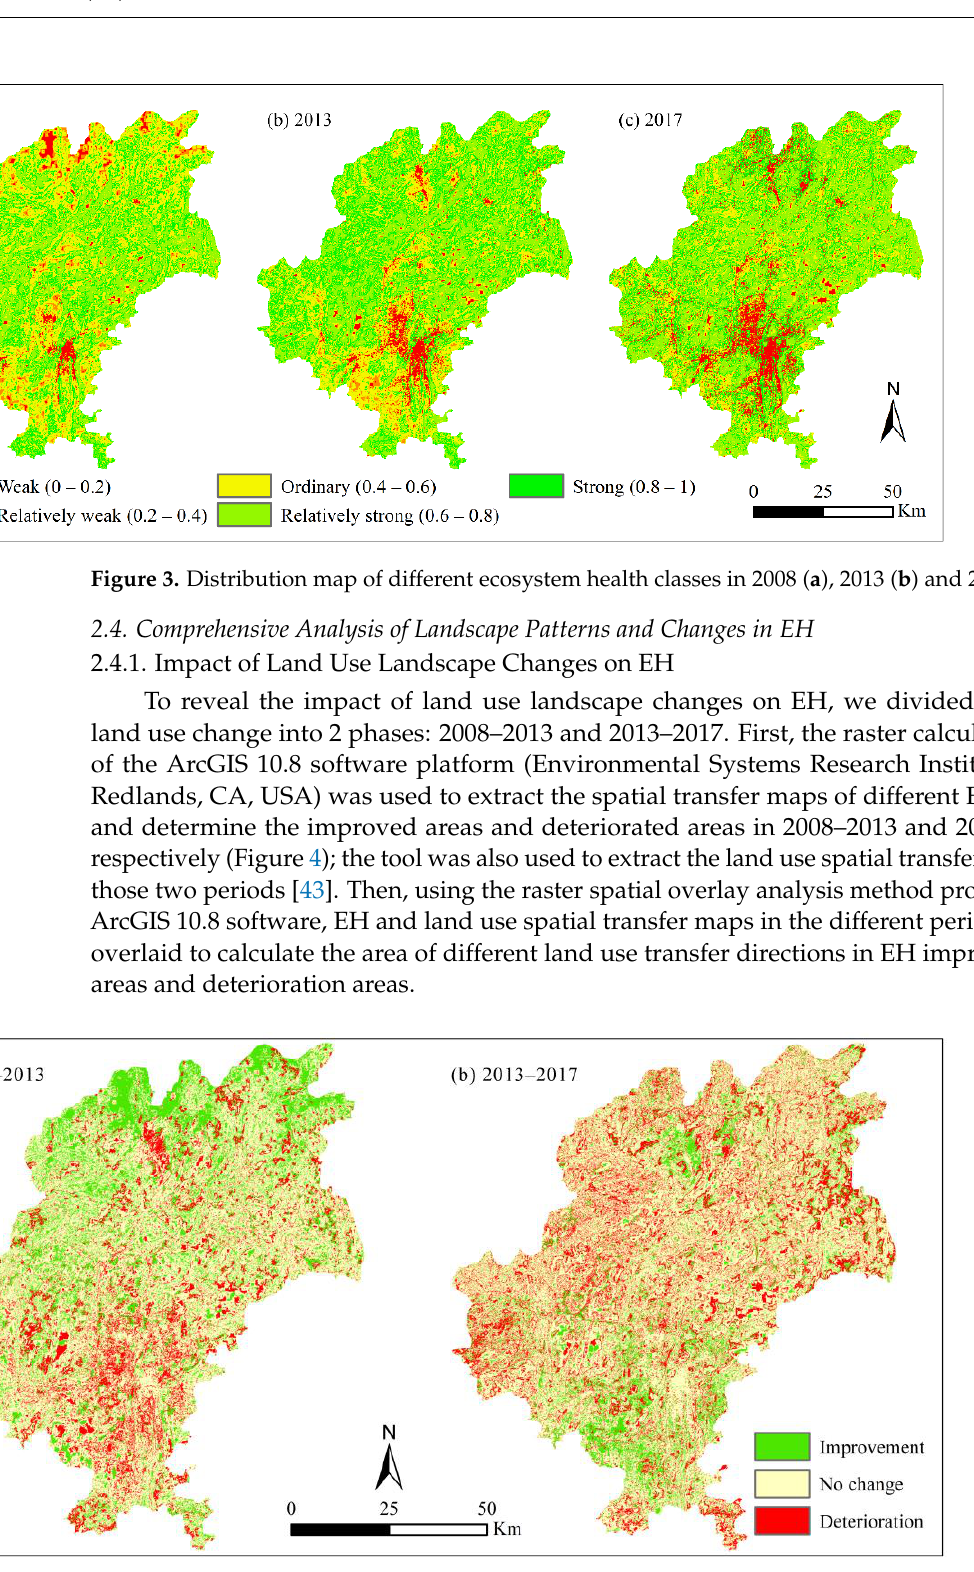
Figure 4. Ecosystem health changes in Guiyang City in 2008 – 2013 ( a ) and 2013 – 2017 ( b ).